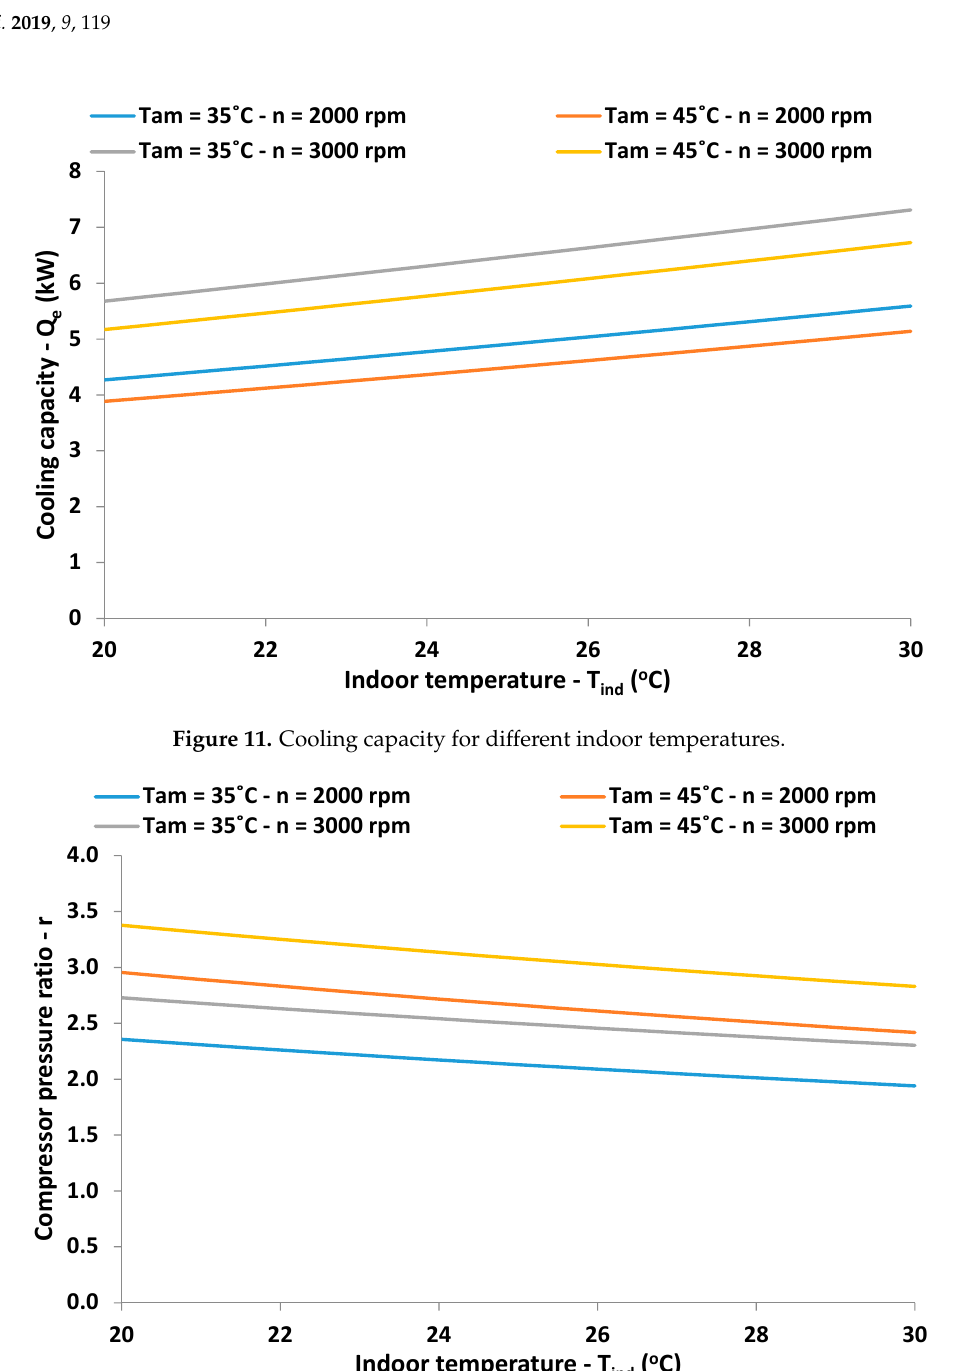
Figure 12. Compressor pressure ratio for different indoor temperatures.